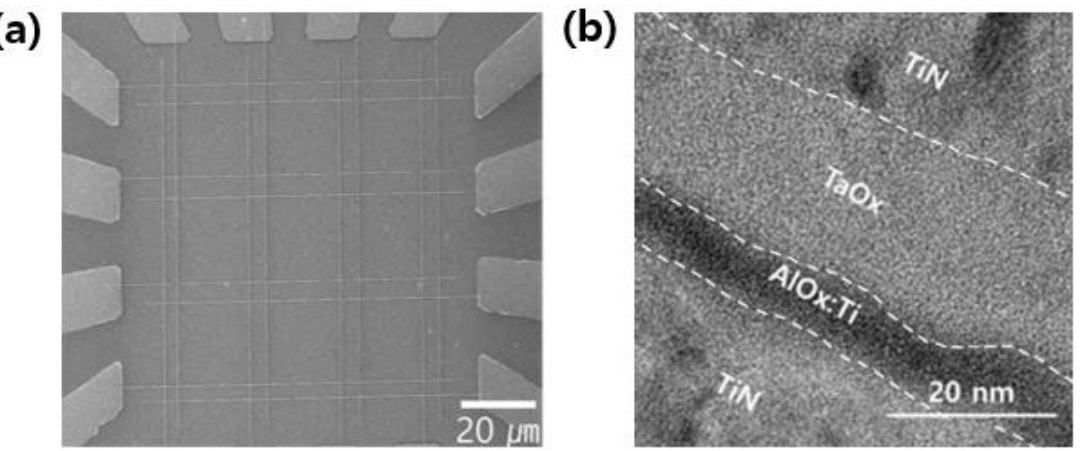
Figure 1. ( a ) SEM image from the top of TiN/AlO x :Ti/TaO x /TiN device. ( b ) TEM image of TiN/AlO x :Ti/TaO x /TiN.